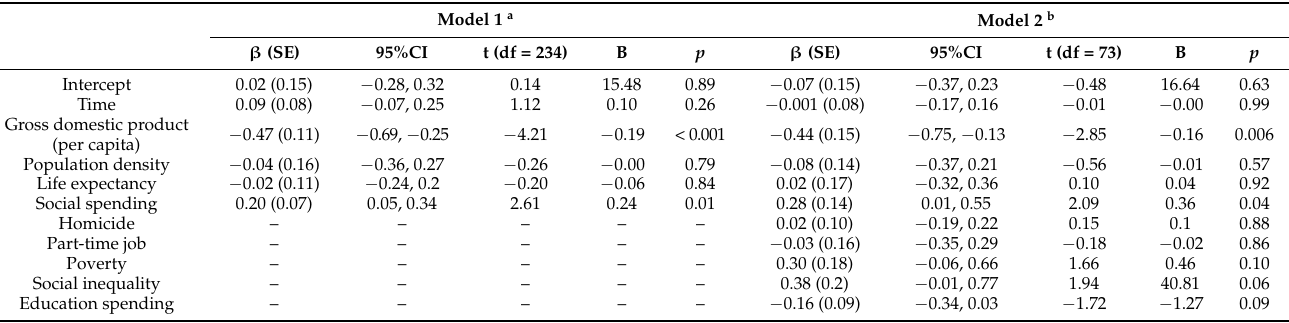
Table 1. Results of mixed models predicting associations between the NEET rate and the variables of interest, 1997–2020 (OECD